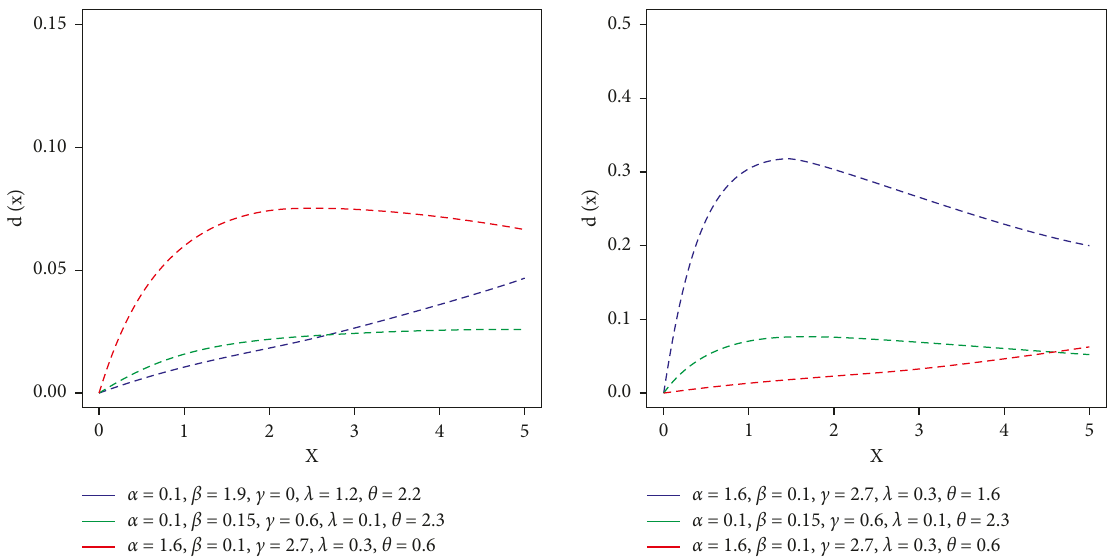
Figure 2: Hazard plot of some parameter values for GA_L.